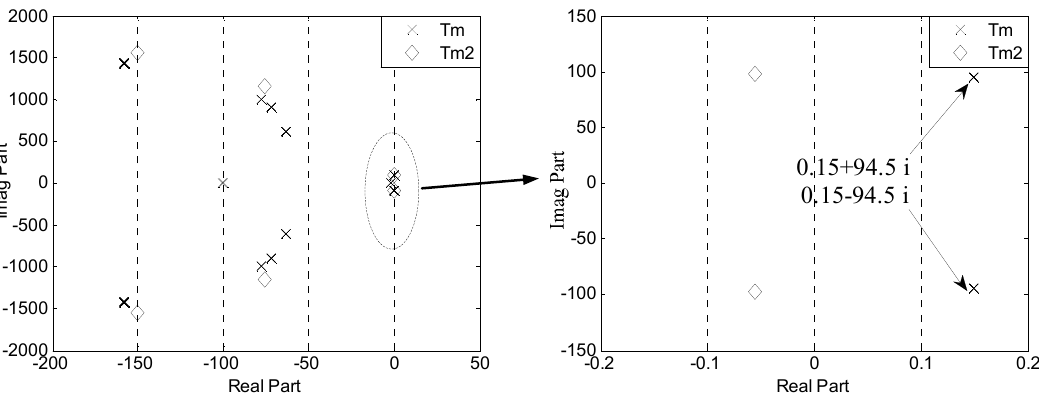
Figure 10. The dominant poles of T m ans T m 2 when the cables are long.